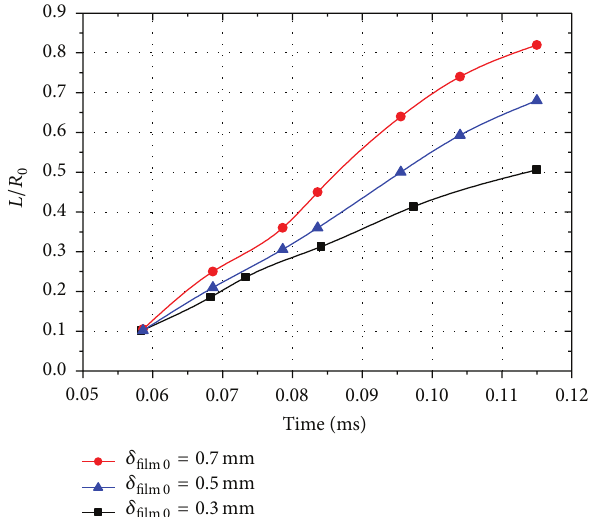
Figure 8: Aspect ratio of filament length to droplet radius with time for different film thicknesses.